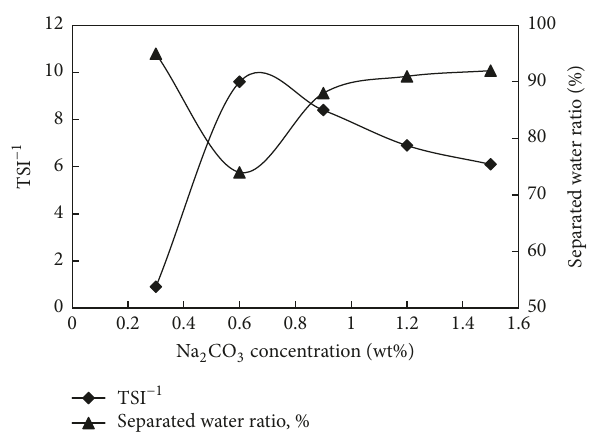
Figure 6: Relationship of TSI −1 and separated water ratio when Na 2 CO 3 concentration varies. The surfactant concentration is 0.3 wt% and polymer concentration is 2000